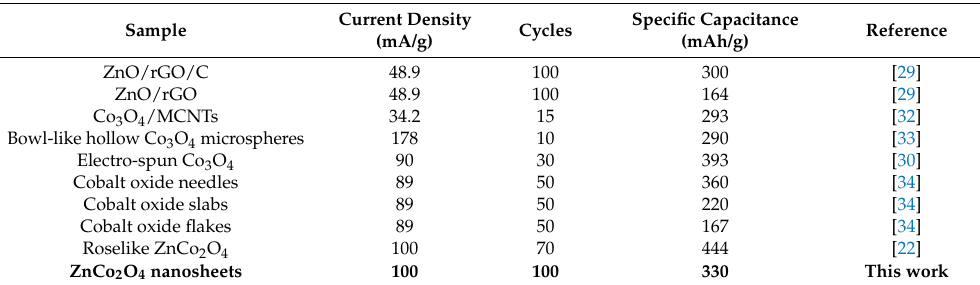
Table 1. Electrochemical properties comparison of the ZnCo 2 O 4 nanosheets with ZnO and Co 3 O 4 as the anode in sodium ion